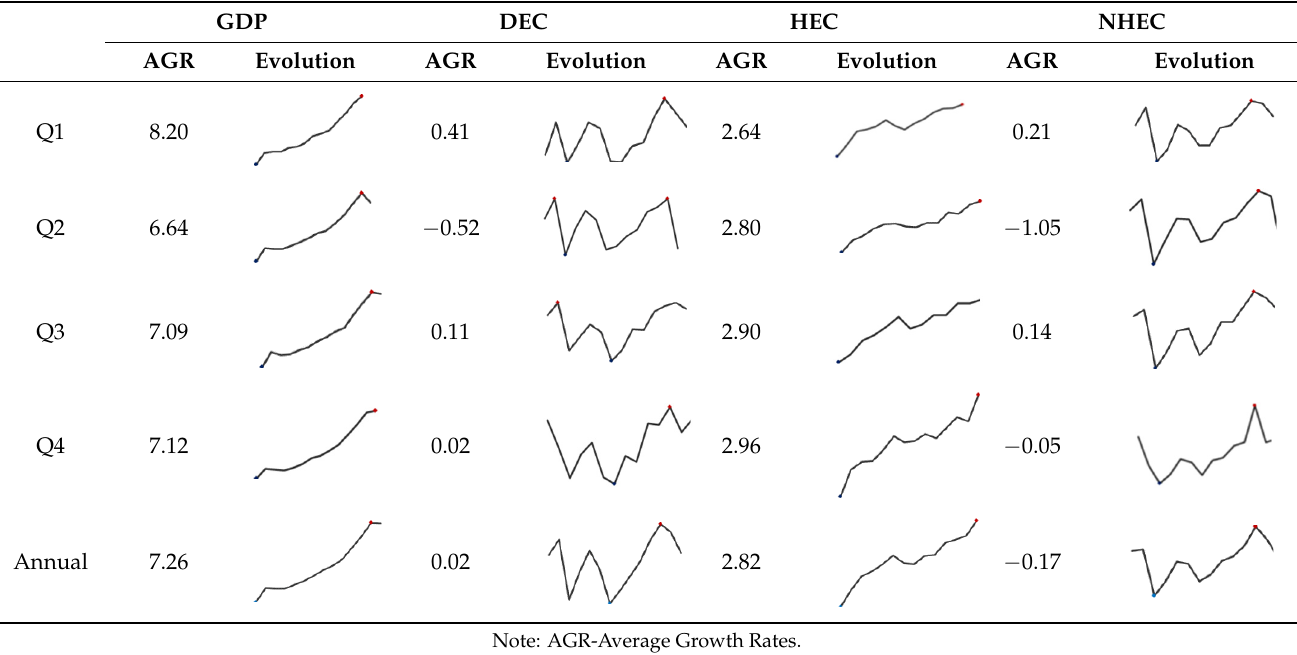
Figure 2. Evolution of GDP during financial crisis and COVID-19 crisis. The average GDP growth rate (both annually and quarterly), as well as the evolution in the period 2007–2019 shows a permanent increase even during the financial crisis, but from the second quarter of 2020, there is a slight decrease (Table 1). The actual growth rate in 2020 compared to 2019 being − 0.55%, significantly greater than the forecasted one. Table 1. Analysis of the average annual and quarterly rate (AGR) and the graph of the evolution of the indicators in the period 2007–2020. GDP